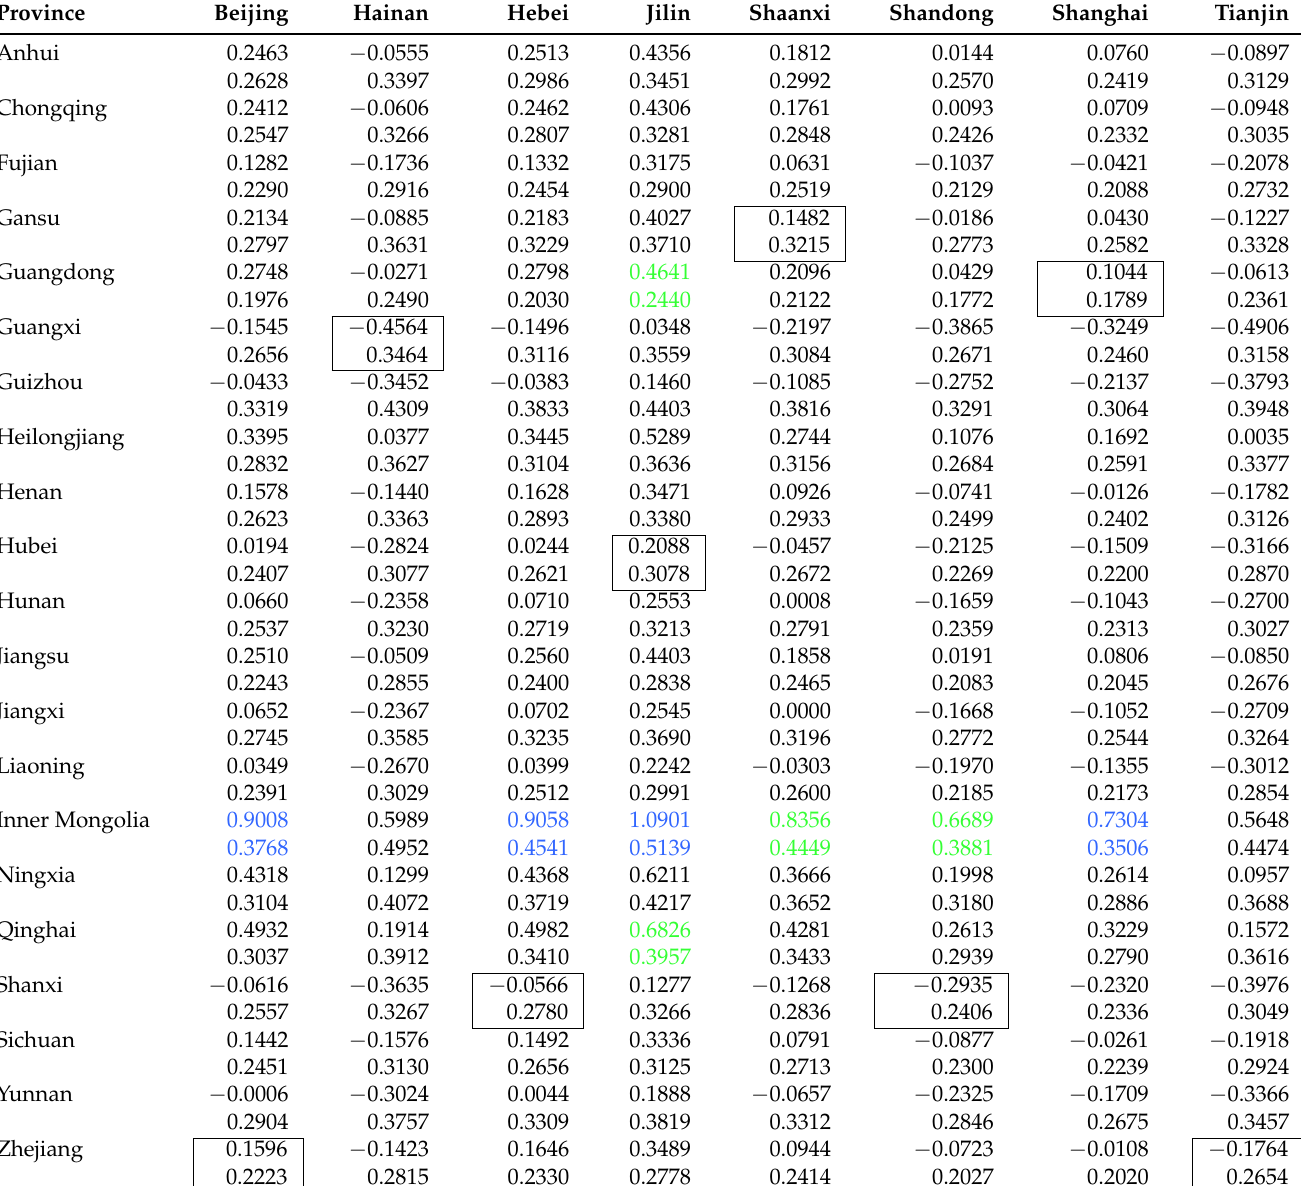
Table 5. ATET estimates (with corresponding standard error listed beneath) for each treated (column) vs. each control (row) province (for all individuals) for the number of working days: Significance of point estimates at the arbitrary 1, 5, and 10 percent levels are colored red, blue, and green, respectively—a box is given for the control province most closely aligned with the treatment province in terms of absolute minimum